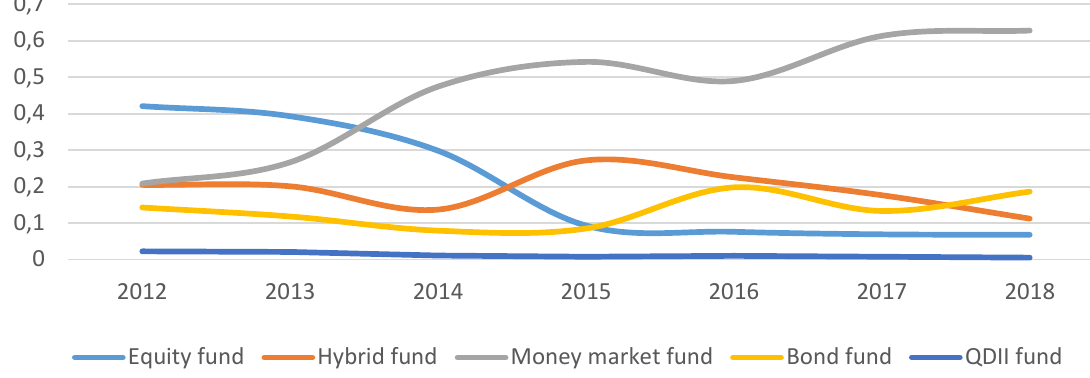
Figure 4. The proportion of assets under